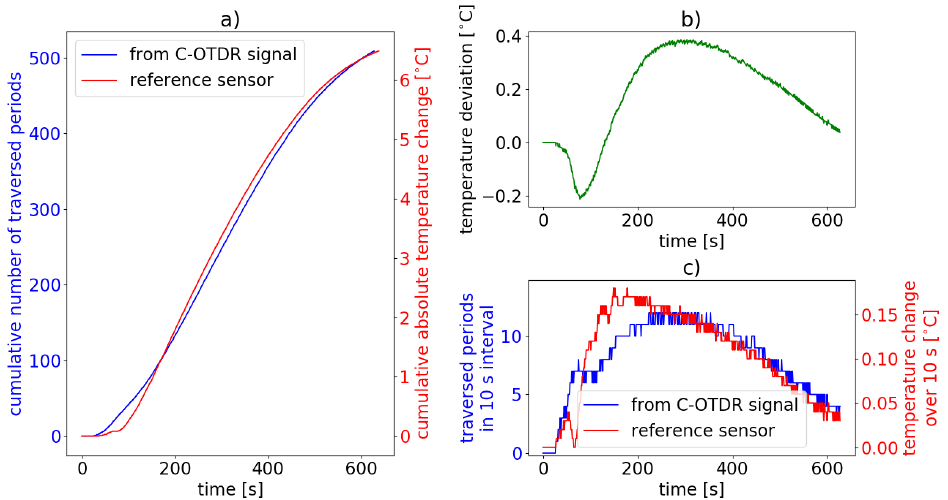
Figure 8. Distributed temperature gradient sensing result for single sensor position during heating process. ( a ) cumulative number of traversed periods from the C-OTDR trace (blue) and temperature as measured by the reference thermistor (red), ( b ) deviation between measured relative temperature increase and temperature increase as calculated from Equation (6), ( c ) corresponding number of traversed periods (blue) and simultaneously measured temperature changes (red), both over 10 s